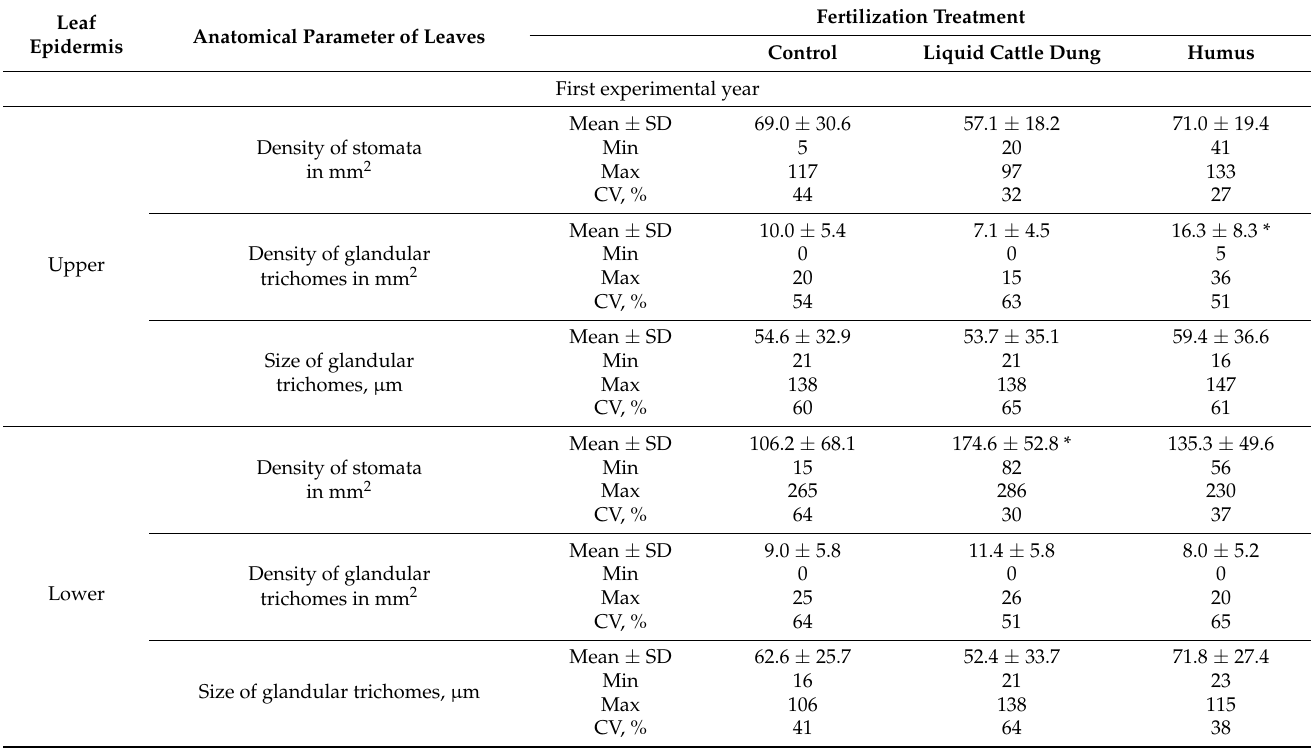
Table 4. Descriptive statistics of anatomical parameters in the upper and lower epidermis of Thy- mus × citriodorus depending on the fertilization treatment in the first and second experimental years. SD—standard deviation; CV—coefficient of